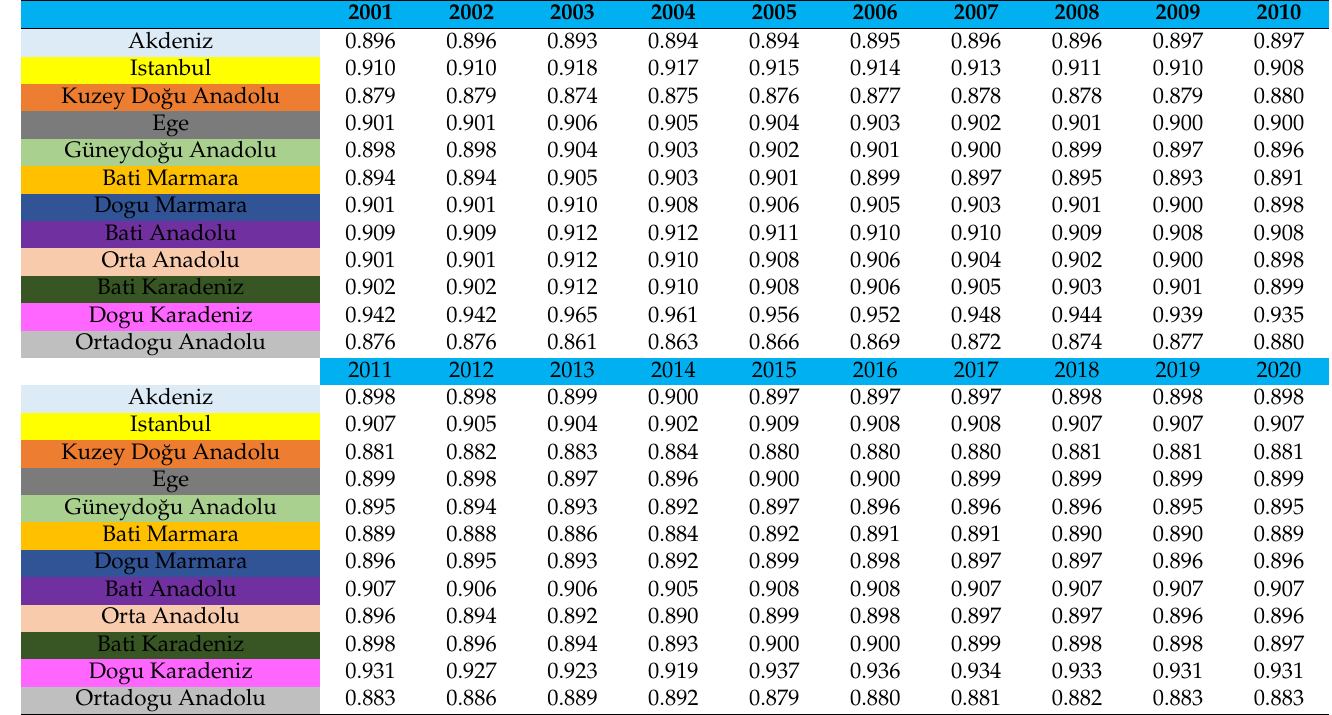
Table 14. Estimated Life Expectancy index—Turkey